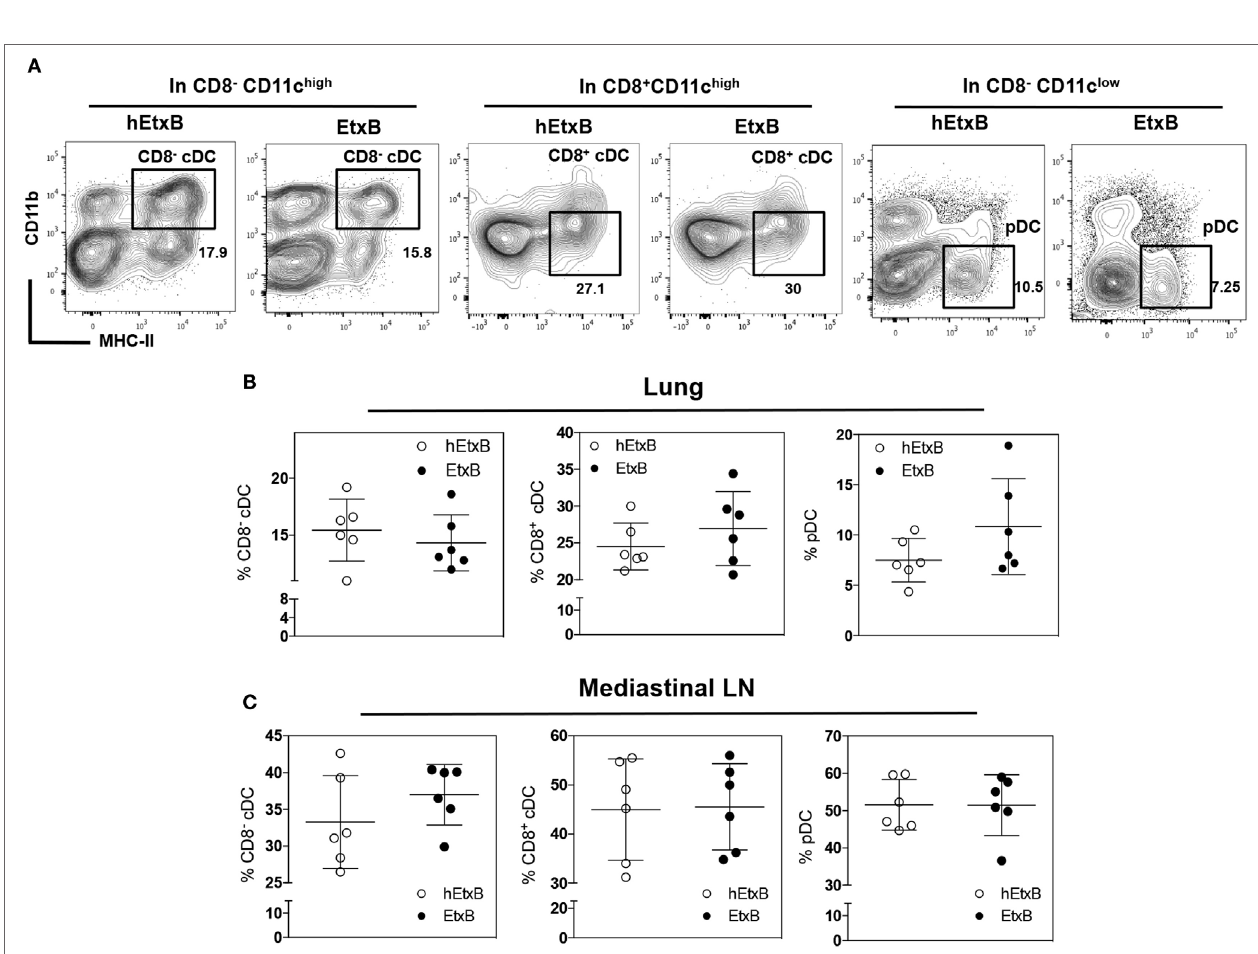
FigUre 3 | etxB does not alter mature dendritic cell (Dc) subsets . C57BL/6 mice were treated intranasally with 100 μ g/mouse EtxB or heat-EtxB (hEtxB) for 3 days. On day 2.5 posttreatment, lung and mediastinal lymph node (mLN) were removed and analyzed, flow cytometric contour plots (a) and dot plots show the proportion of DCs subsets in the lung (B) and mLN (c) . Subsets of DC include plasmacytoid DC (pDC, CD11c low CD11b − CD8 − MHC-II + ), CD8 − and CD8 + conventional DCs (CD8 + or CD8 − cDC, CD11c high CD11b + CD8 − / + MHC-II + ). Results are from one experiment representative of six mice in each group from three independent experiments In dot plots, the mean and SD are represented and each circle represents one mouse: white dots hEtxB-treated animals, black dots EtxB-treated